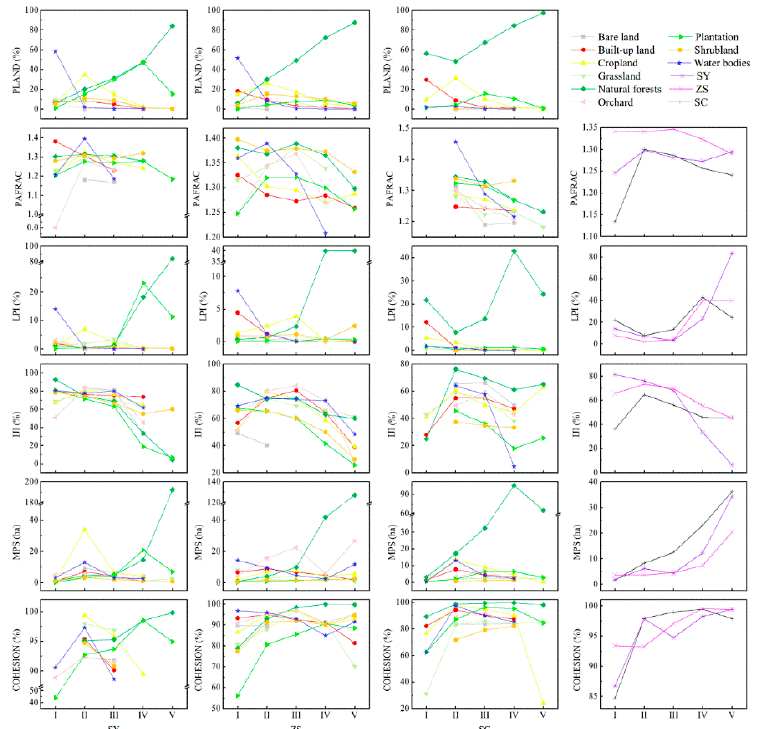
Figure 5. Variations and average trends of landscape indices along the altitude gradients in Shaoyang (SY), Zhushan (ZS), and Shicheng (SC) counties in 2013.